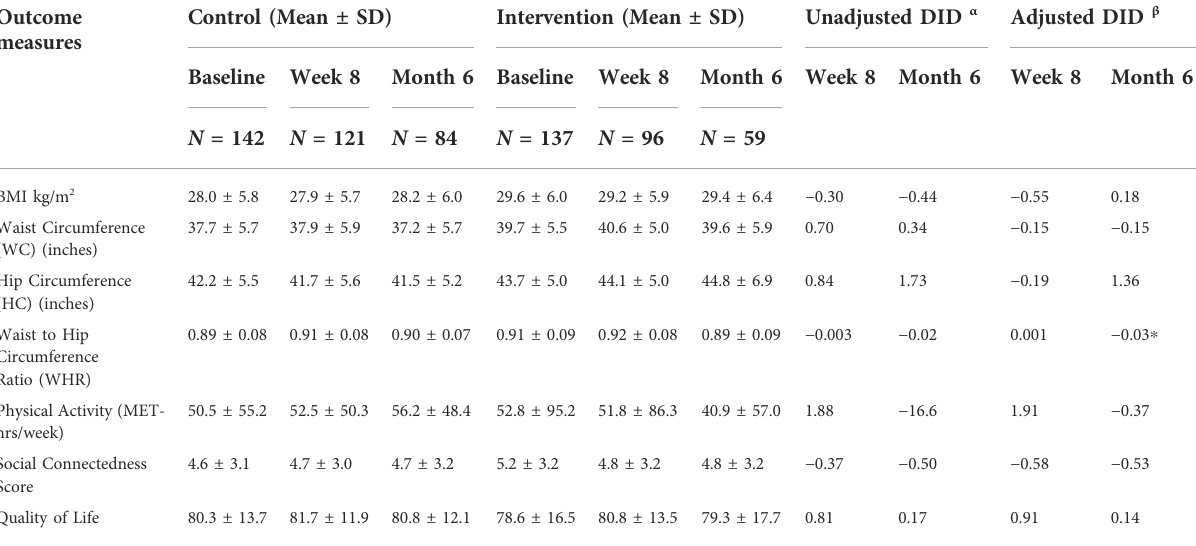
TABLE 5 Intervention impact on body mass index, waist-to-hip circumference ratio, physical activity, social connectedness, and quality of life (all participants). Outcome